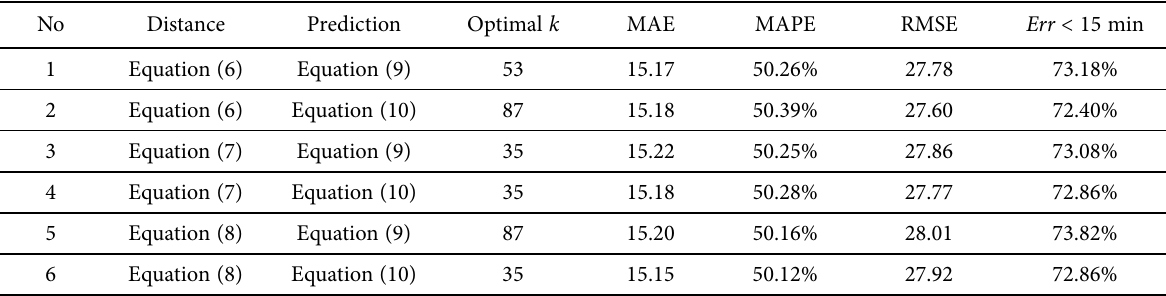
Table 4. Prediction results with different distance metrics and prediction algorithms